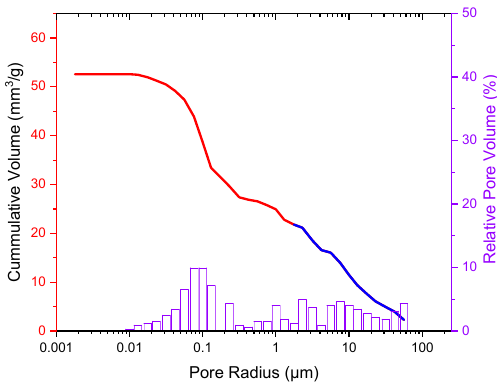
Figure 4. Pore size distribution of the β -TCP determined using Pascal 140 (blue curve) and 440 (red curve) mercury porosimeter, relative pore volume (%) in violet.